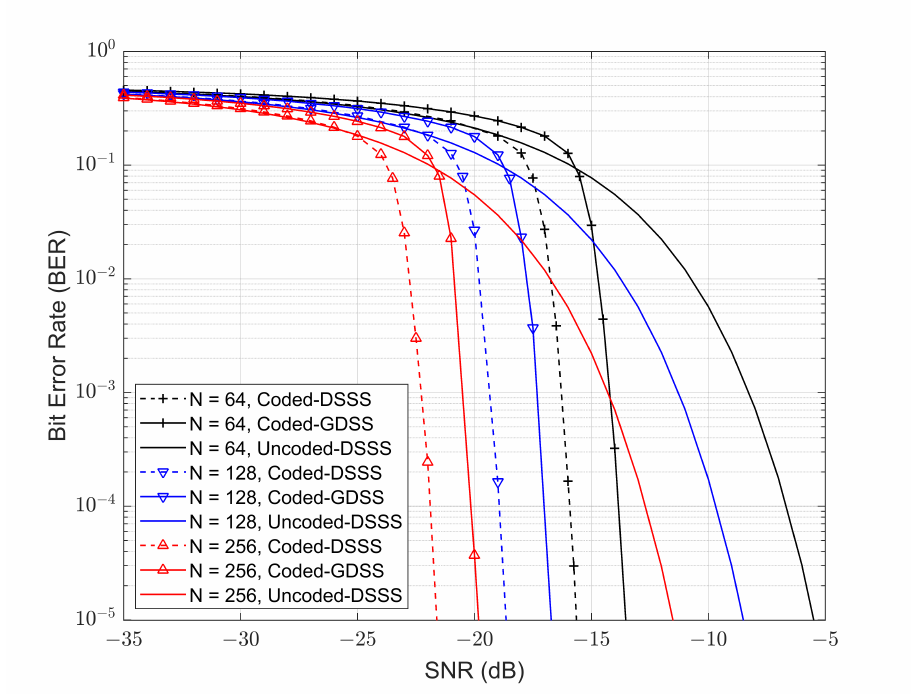
Figure 15. Comparison of LDPC encoded GDSS QPSK system with varying spreading factors against the theoretical DSSS QPSK system’s upper performance